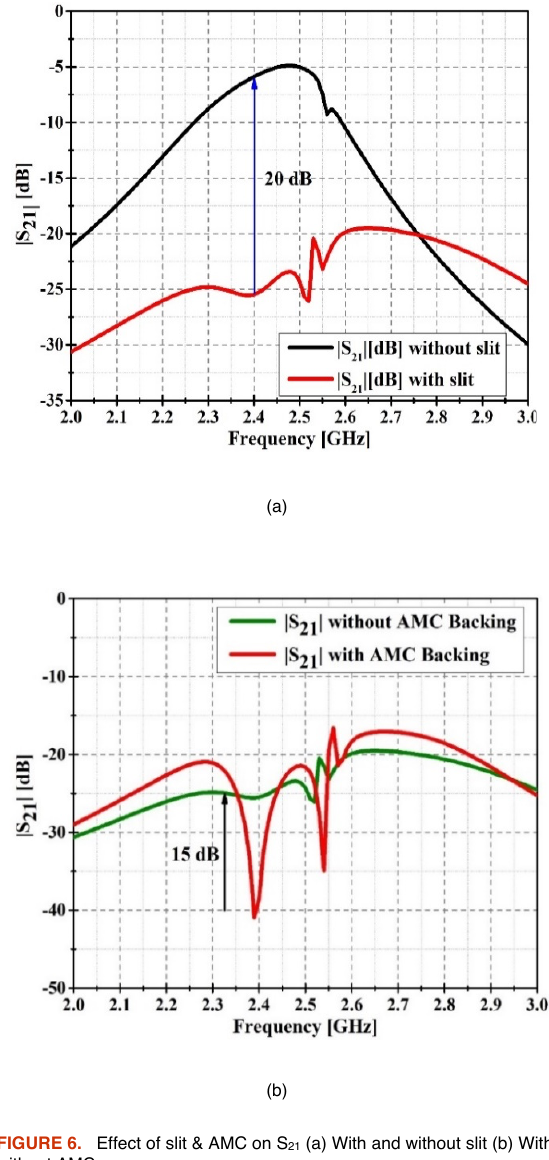
FIGURE 6. Effect of slit & AMC on S 21 (a) With and without slit (b) With and without AMC